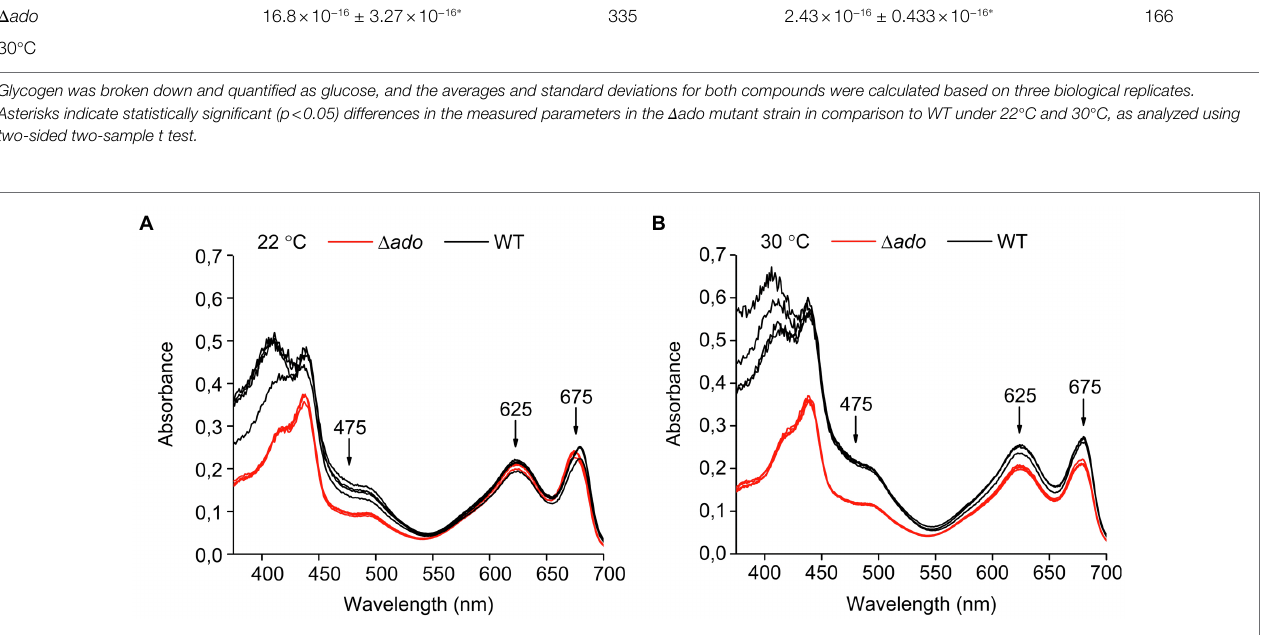
FIGURE 5 | Absorption profiles of Synechocystis sp. PCC 6803 WT (black line) and Δ ado (red line) strains recorded between 370–700 nm from four independent replicates. The cells were grown for 4 days at (A) 22 ° C and (B) 30 ° C and adjusted to OD 750 = 0.3 before the measurement. The arrows indicate the absorption maxima for carotenoids (~475 nm), Chl a (~625 nm) and phycocyanin (~675